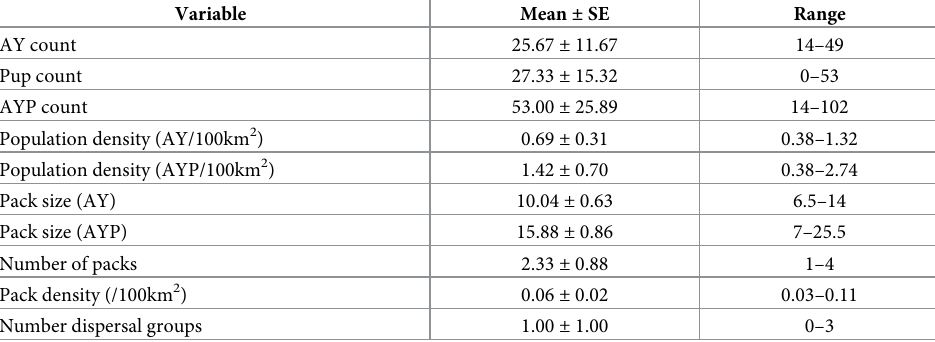
Table 2. Descriptive patterns of annual population dynamics for the reintroduced wild dog population in Goron- gosa National Park between June 2018 and September 2020.